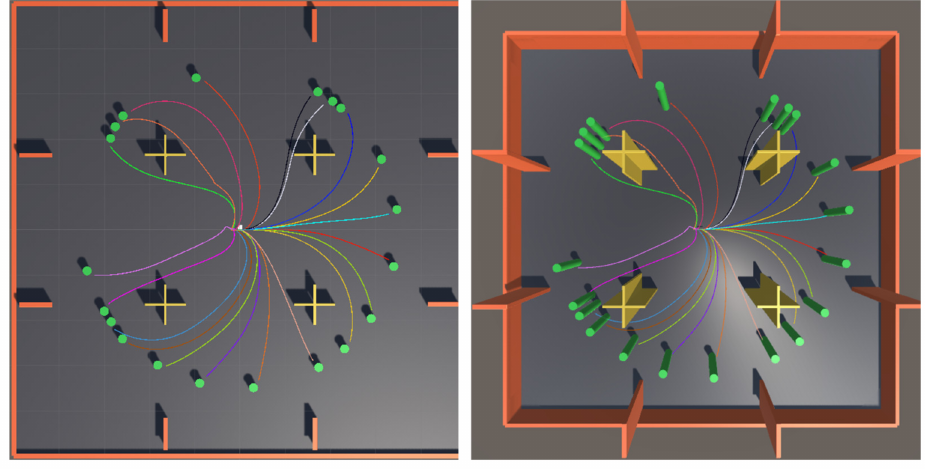
Figure 11. AUV motion